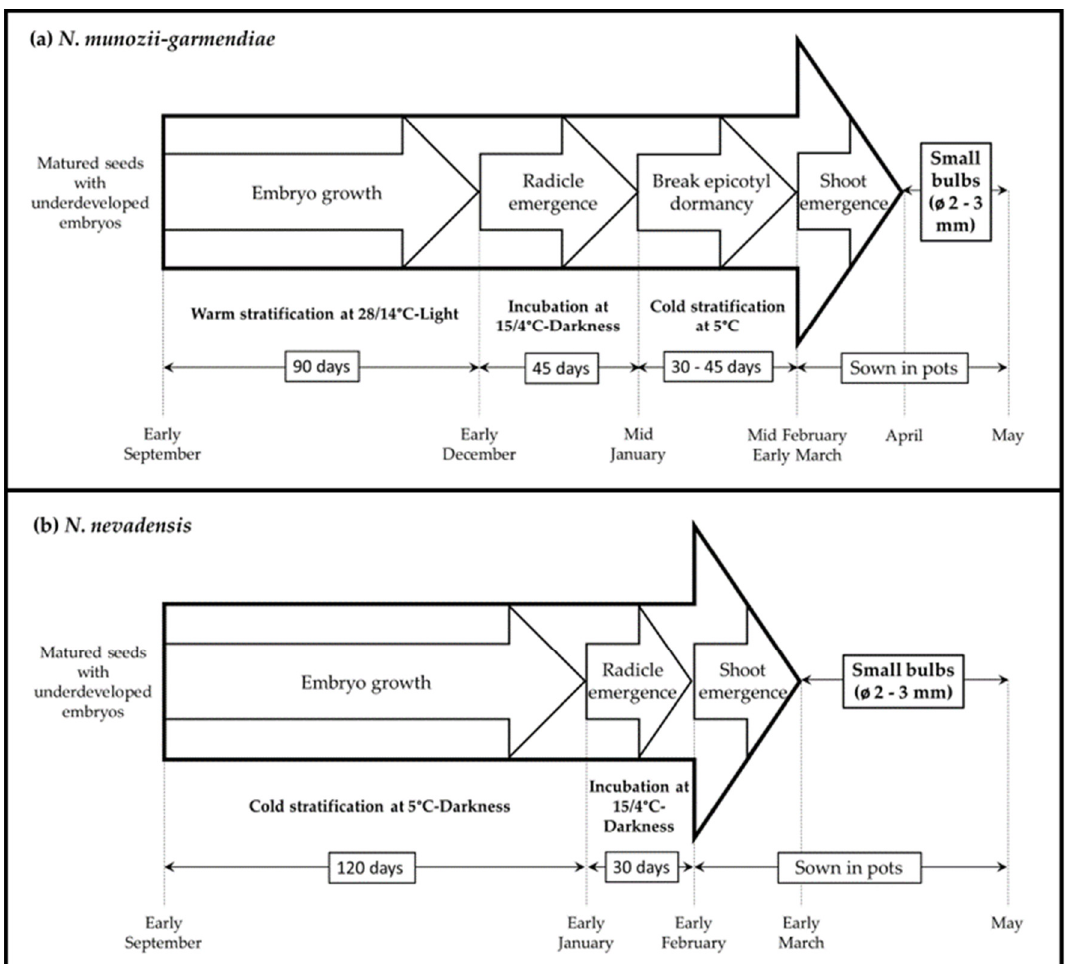
Figure 7. Protocols for plant production from the seeds of N. munozii-garmendiae ( a ) and N. nevadensis ( b ).